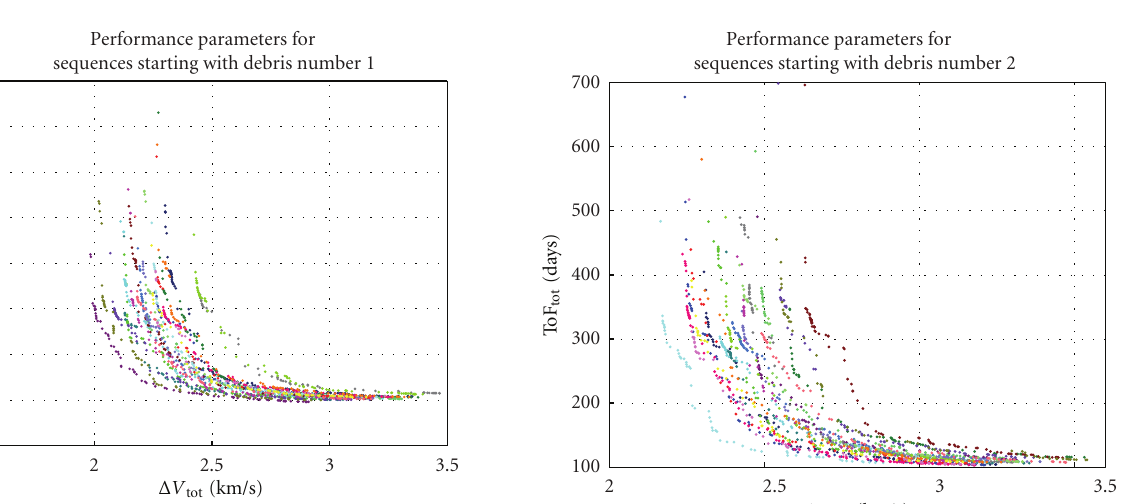
plane changes are 1.47 ◦ , 2.52 ◦ , 1 ◦ , and 2 ◦ . On the contrary, 3.63 ◦ , 2.65 ◦ , 1.95 ◦ , and 1 ◦